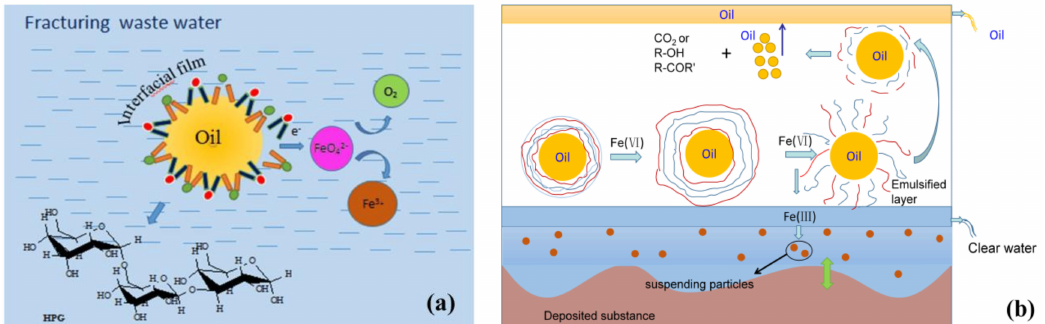
Figure 6. The possible mechanism of the oxidation process, showing ( a ) demulsification and ( b )